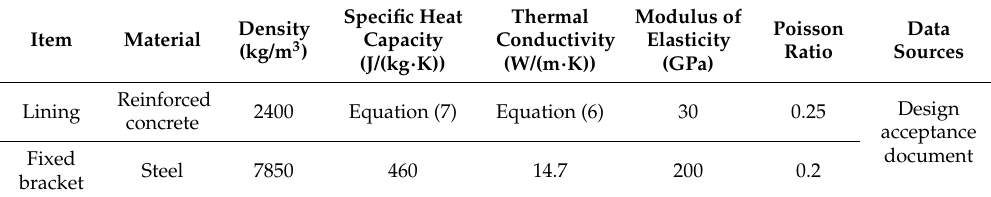
Table 3. Parameters of structure.